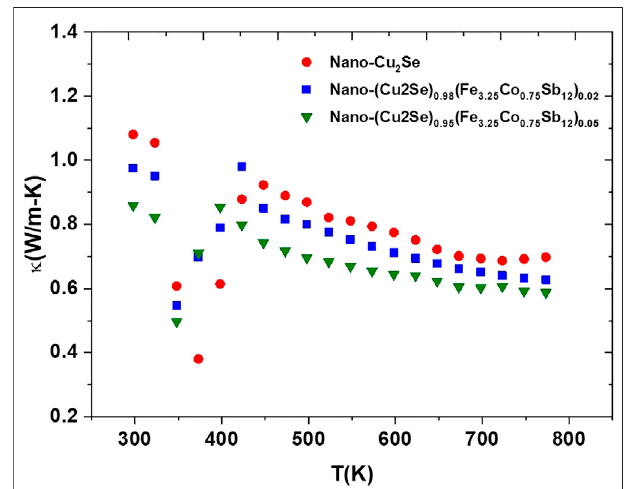
FIGURE 7 | Temperature dependent Seebeck coef fi cient of nano- Cu